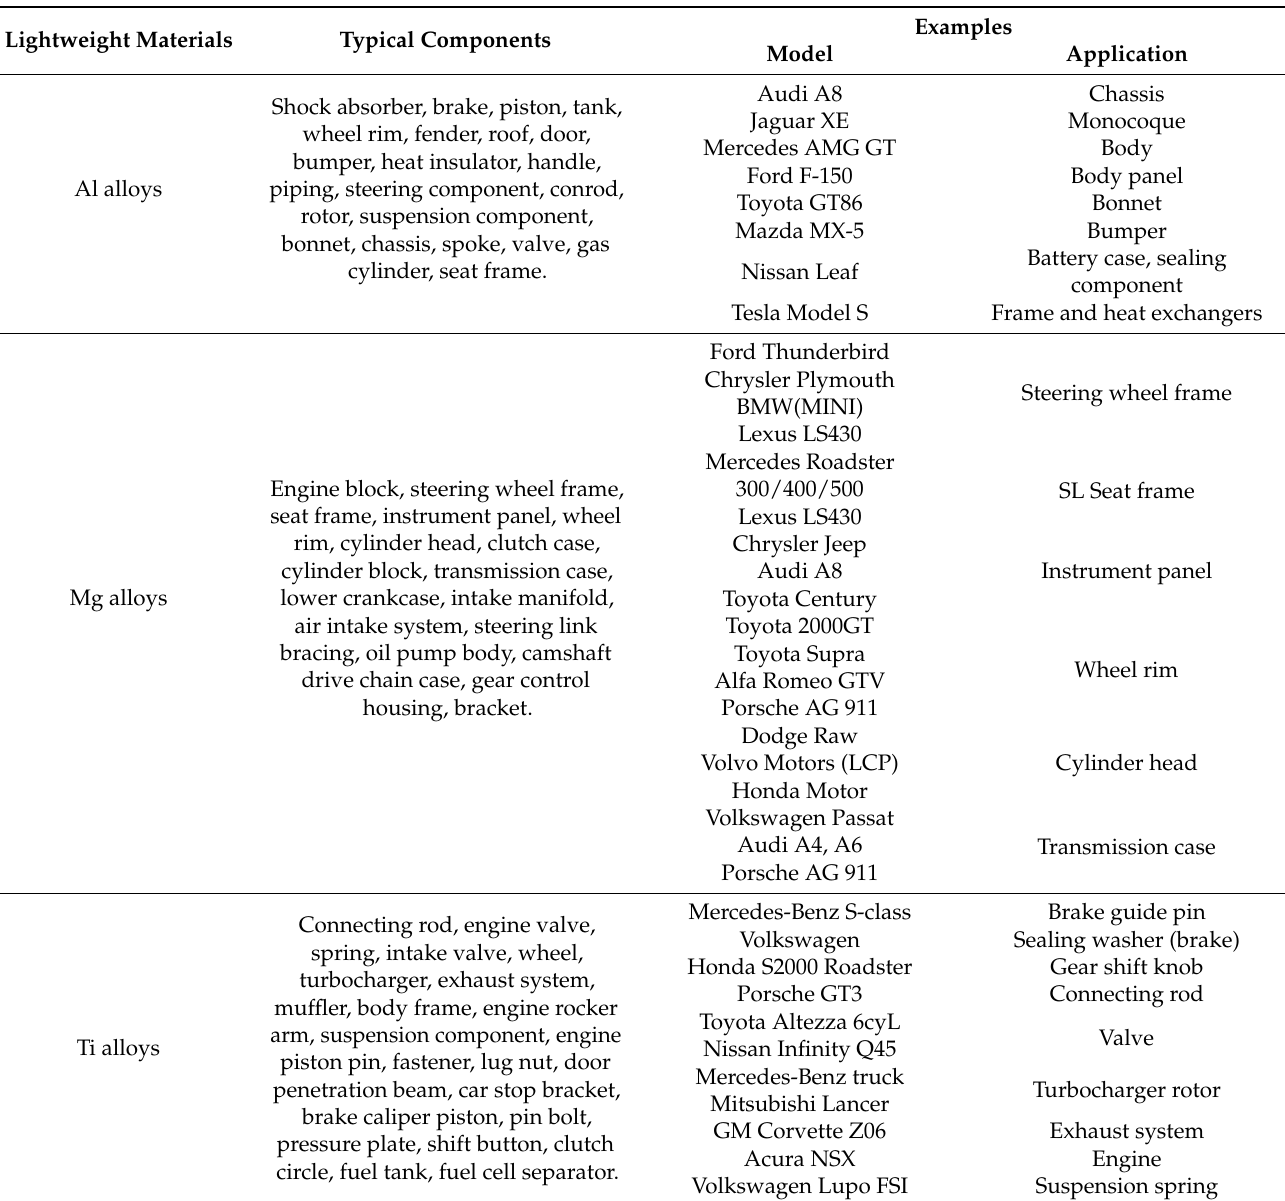
Table 1. Summary of representative lightweight materials for automobiles. Reused from Ref. [9], open